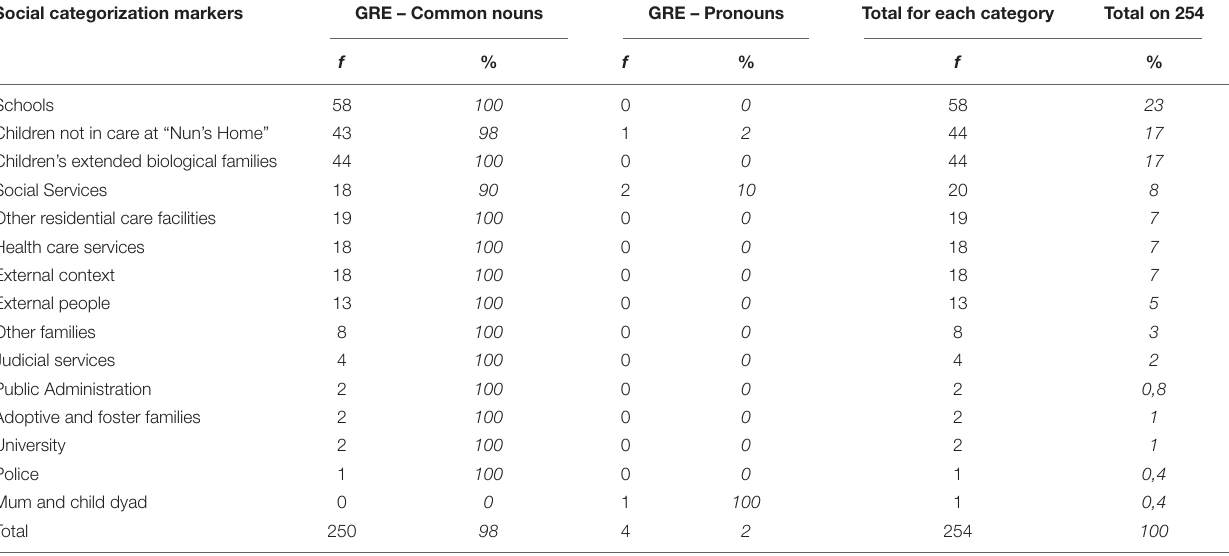
TABLE 3 | Frequency and percentage of external stakeholder (outgroup) social categorization markers. Social categorization markers